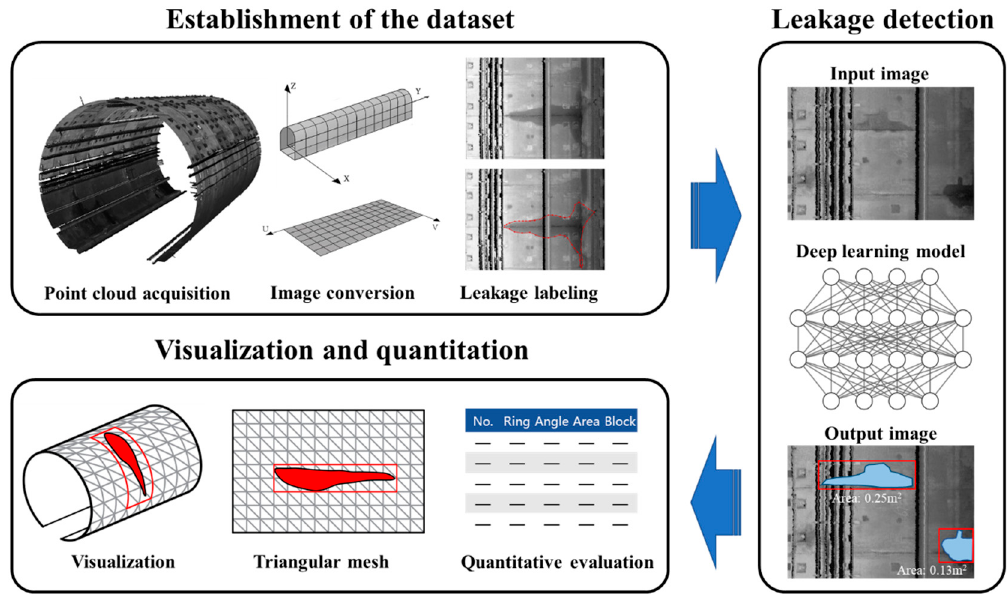
Figure 1. Schematic workflow of the proposed method.